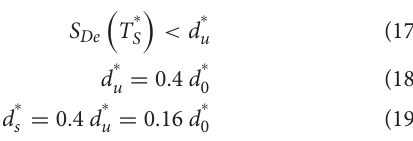
Frontiers in Built Environment |